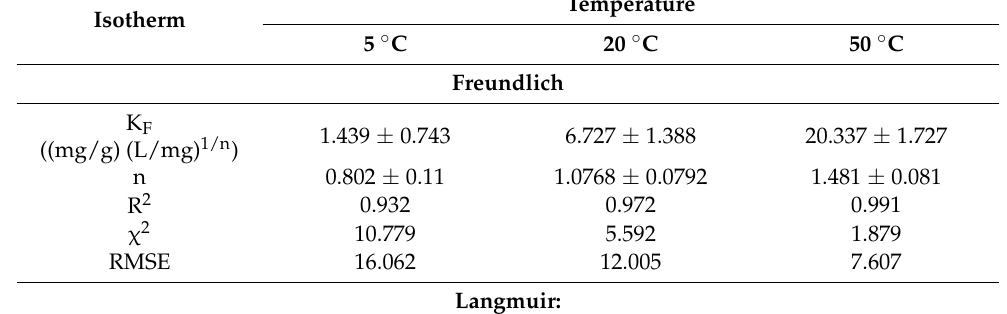
Table 1. The Methylene Blue dye’s biosorption characteristics on a hydrogel-based biosorbent. Temperature Isotherm 5 ◦